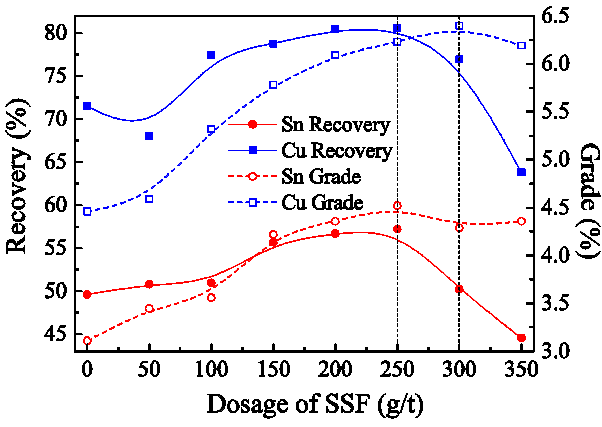
Figure 6. Flotation recovery and grade of Sn and Cu as a function of dosage of SSF (pH = 7.2–7.5; CMC 350 g/t; lead nitrate 200 g/t; BHA 2000 g/t; terpineol 25 g/t).